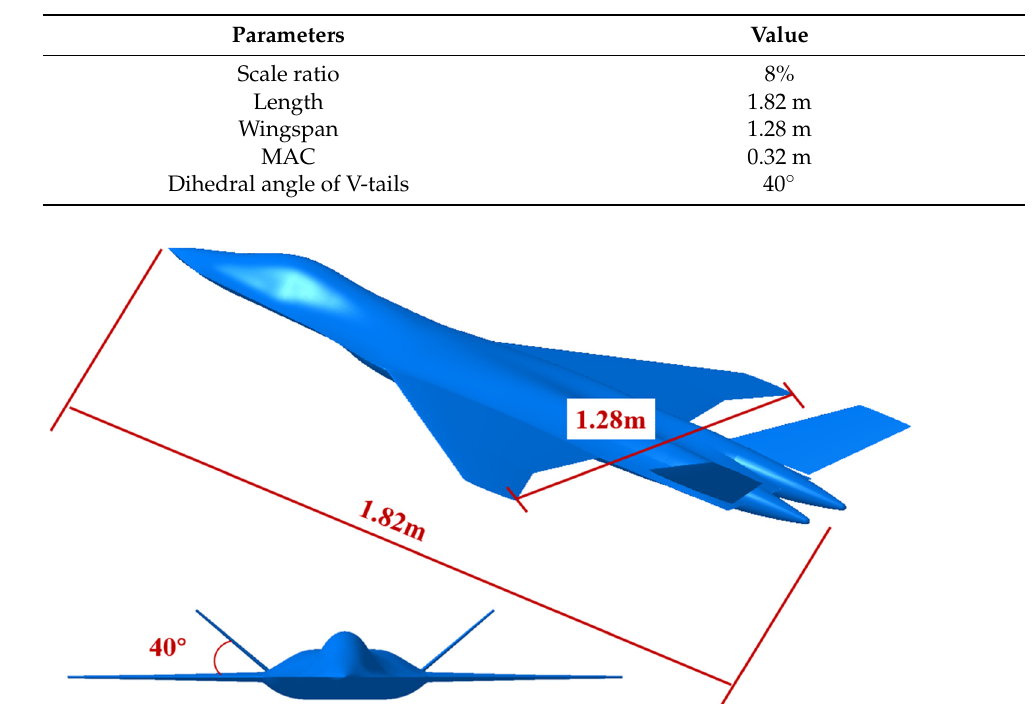
Figure 1. The design process of the aircraft model.